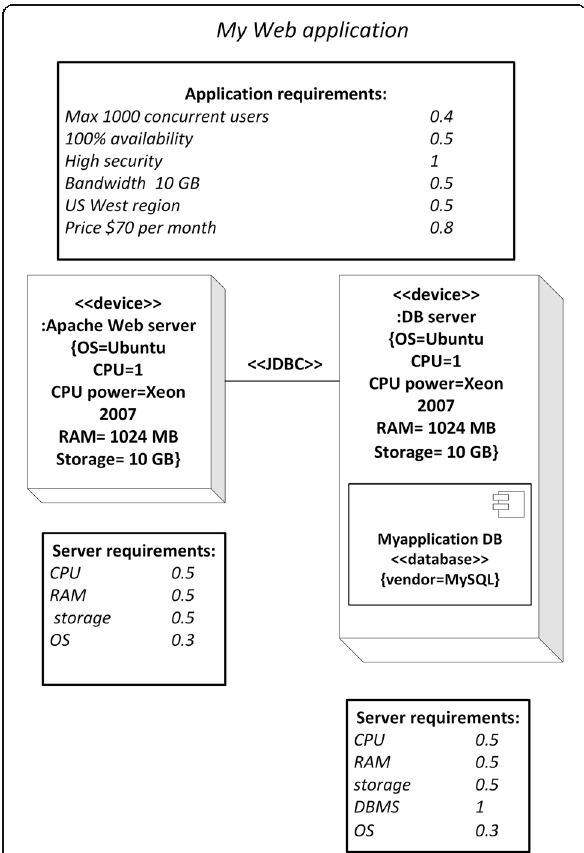
Fig. 1 Deployment components, requirements and customer preferences of a simple